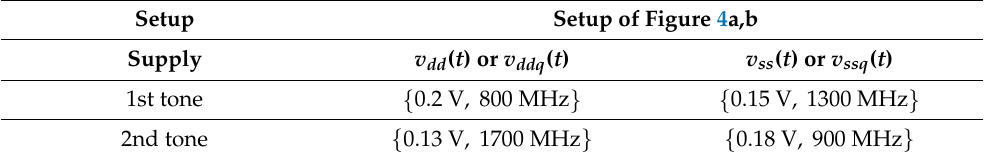
Table 2. PGSV settings of setup Figure 4. Setup Setup of Figure 4a,b Supply